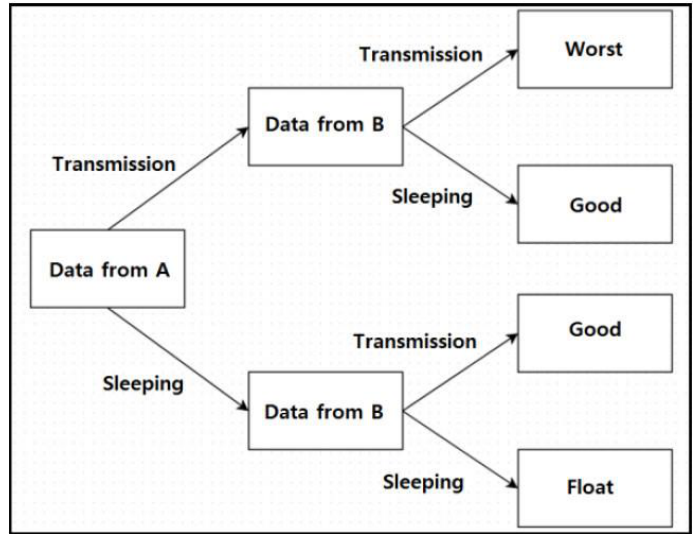
Figure 9. Representation of Zigbee-based communication as an Extensive-form Game.